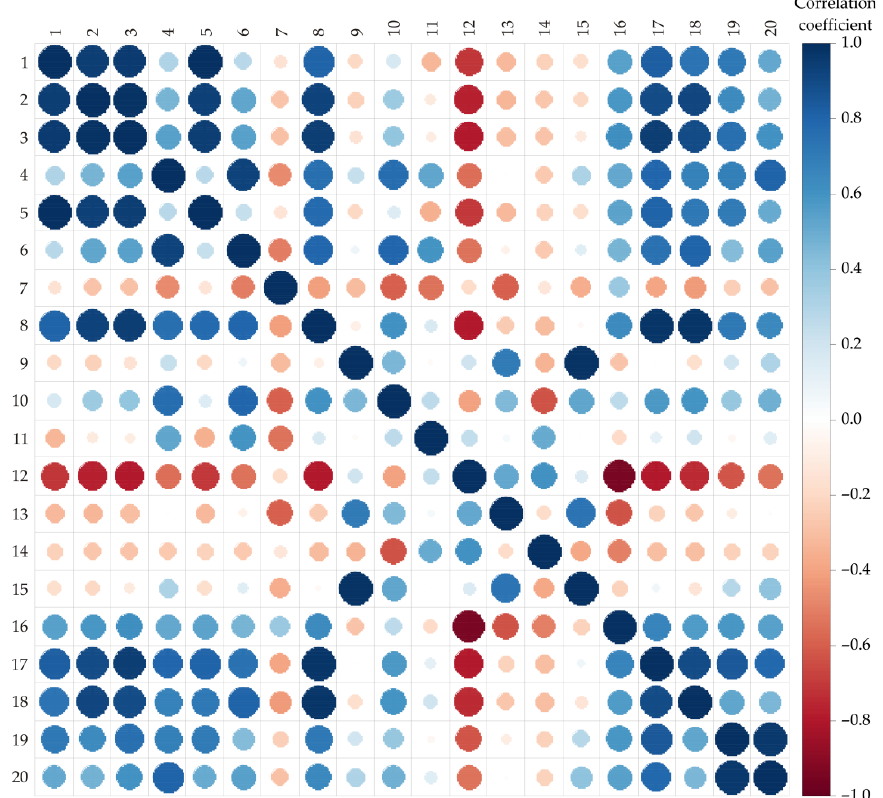
Figure 5. Correlation between volatile compounds of essential oil and hydrolate composition according to this study and literature (the compounds were codded according to Table 6).